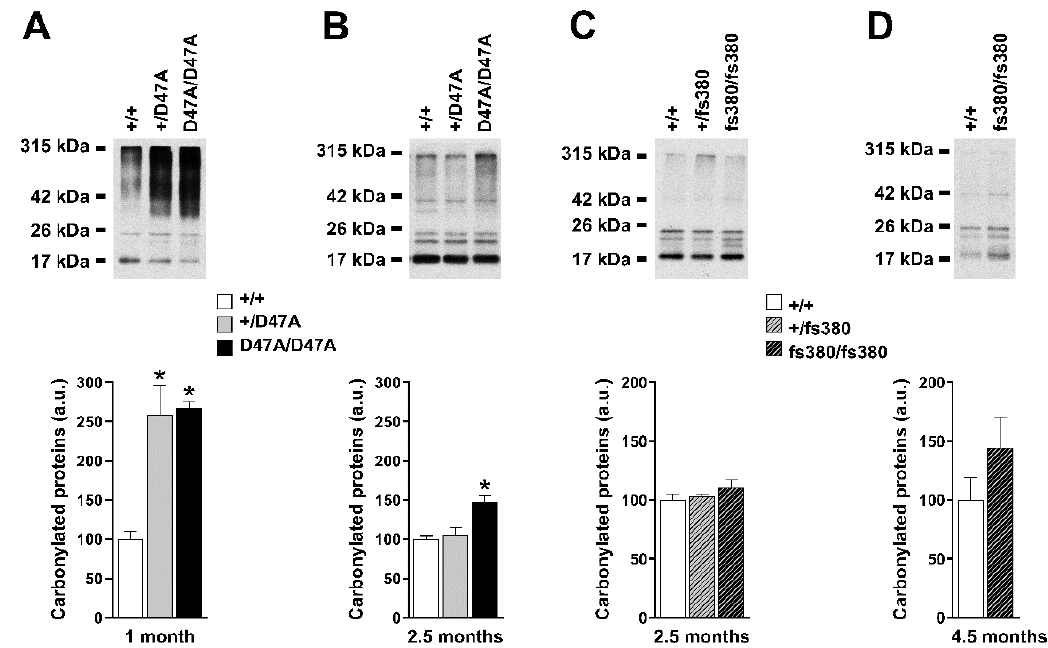
Figure 7. Carbonylated proteins in Cx50D47A and Cx46fs380 lenses. ( A , B ). Top panels. Immunoblots of DNP-derivatized proteins in whole lens homogenates from 1- ( A ) and 2.5- ( B ) month-old mice that were wild type for Cx50 ( +/+ ), or heterozygous ( +/ D47A) or homozygous (D47A / D47A) for Cx50D47A. The migration positions of the molecular mass markers are indicated on the left. Bottom panels. Graphs show the densitometric values of the DNP-derivatized protein bands obtained in three independent experiments. Data are presented as the mean (bar) + standard error of the mean. ( C , D ). Top panels. Immunoblots of DNP-derivatized proteins in samples of whole lens homogenates from 2.5- ( C ) and 4.5- ( D ) month-old mice that were wild type for Cx46 ( +/+ ), or heterozygous ( +/ fs380) or homozygous (fs380 / fs380) for Cx46fs380. Bottom panels. Graphs show the densitometric values of the DNP-derivatized protein bands obtained in three independent experiments. Data are presented as the mean (bar) + standard error of the mean. Asterisk denote a significant di ff erence compared with wild-type lenses ( p < 0.05).